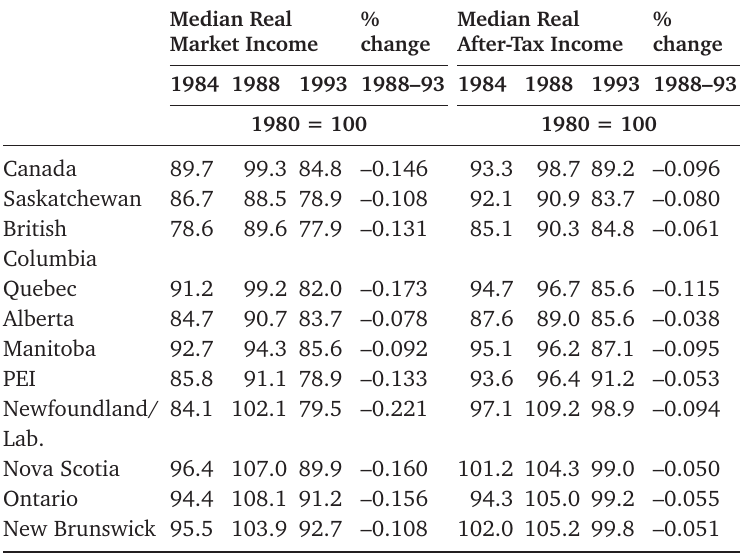
Table 1. Economic Disruption and Living Standards, Canada and Provinces, Economic Families, 1980–93 Median Real Market